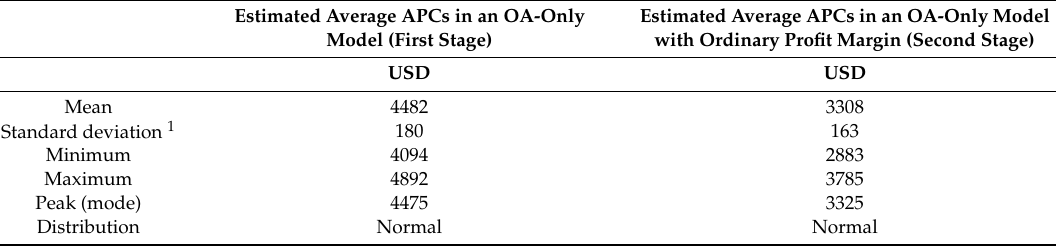
Table 5. Results: comparison of current and estimated average APCs (based on 2017 data).